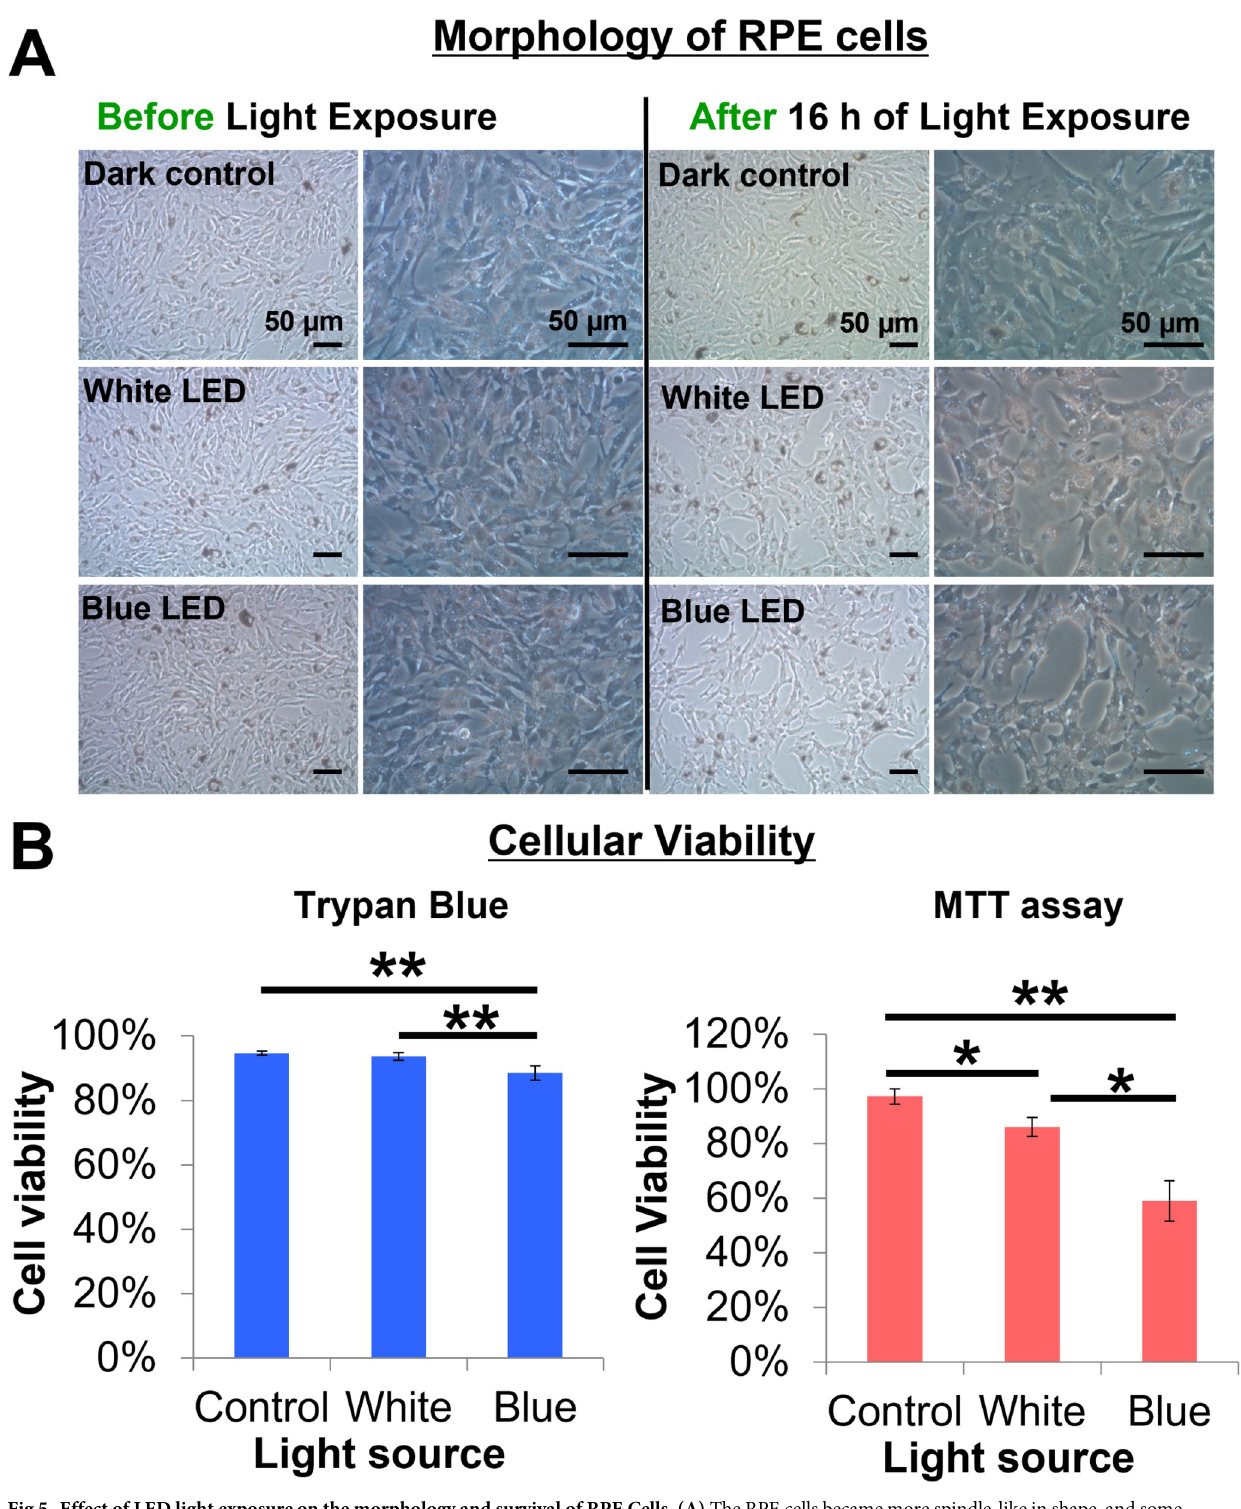
Fig 5. Effect of LED light exposure on the morphology and survival of RPE Cells. (A) The RPE cells became more spindle-like in shape, and some detached from the culture plate after 16 h of light exposure. This was more evident in the blue LED irradiated cells. Scale bar represents 50 μ m. (B) Blue light irradiation significantly induced more cell death compared to white light and the dark control, as shown by trypan blue and MTT assays. Cell viability dropped to 86% and 59% in white and blue LED light, respectively, under MTT assay. (n = 3, one way ANOVA, � p < 0.05, �� p < 0.01.) The values are expressed as Mean ±